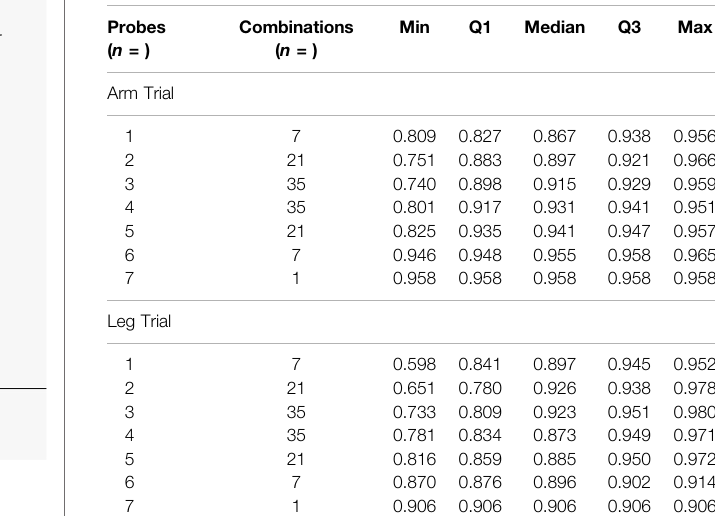
TABLE 4 | The fi ve-number summary of the distribution of ICC values.